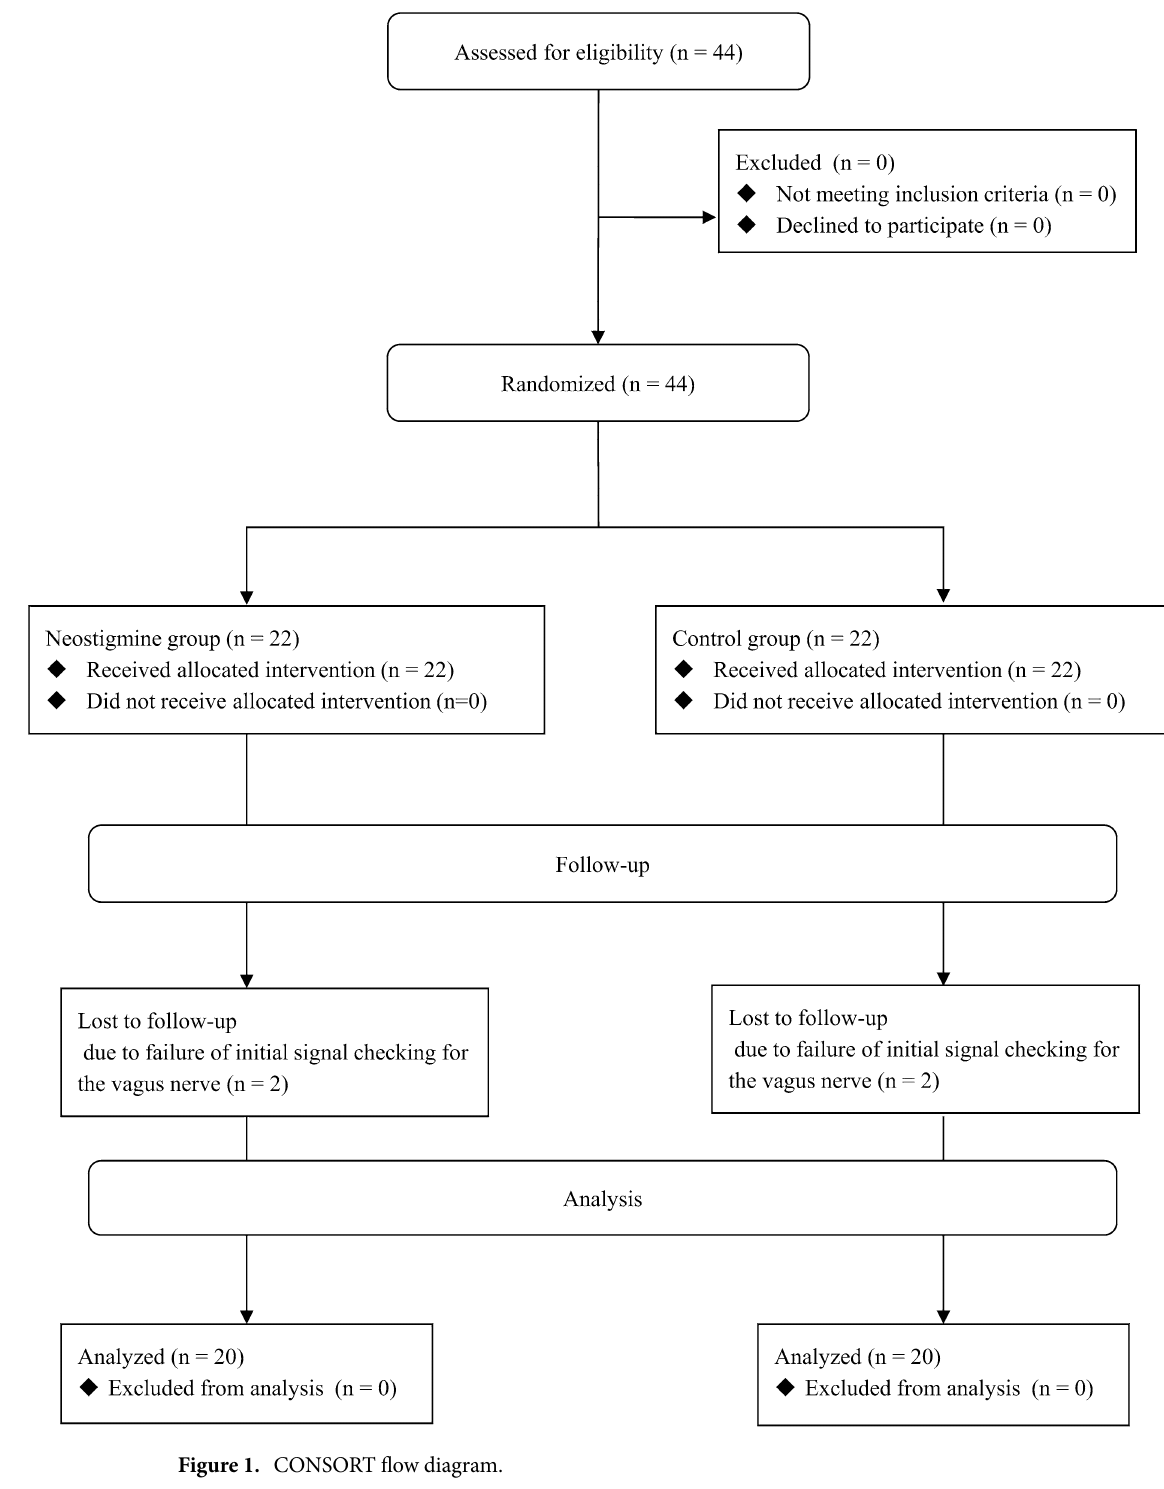
Figure 1. CONSORT flow